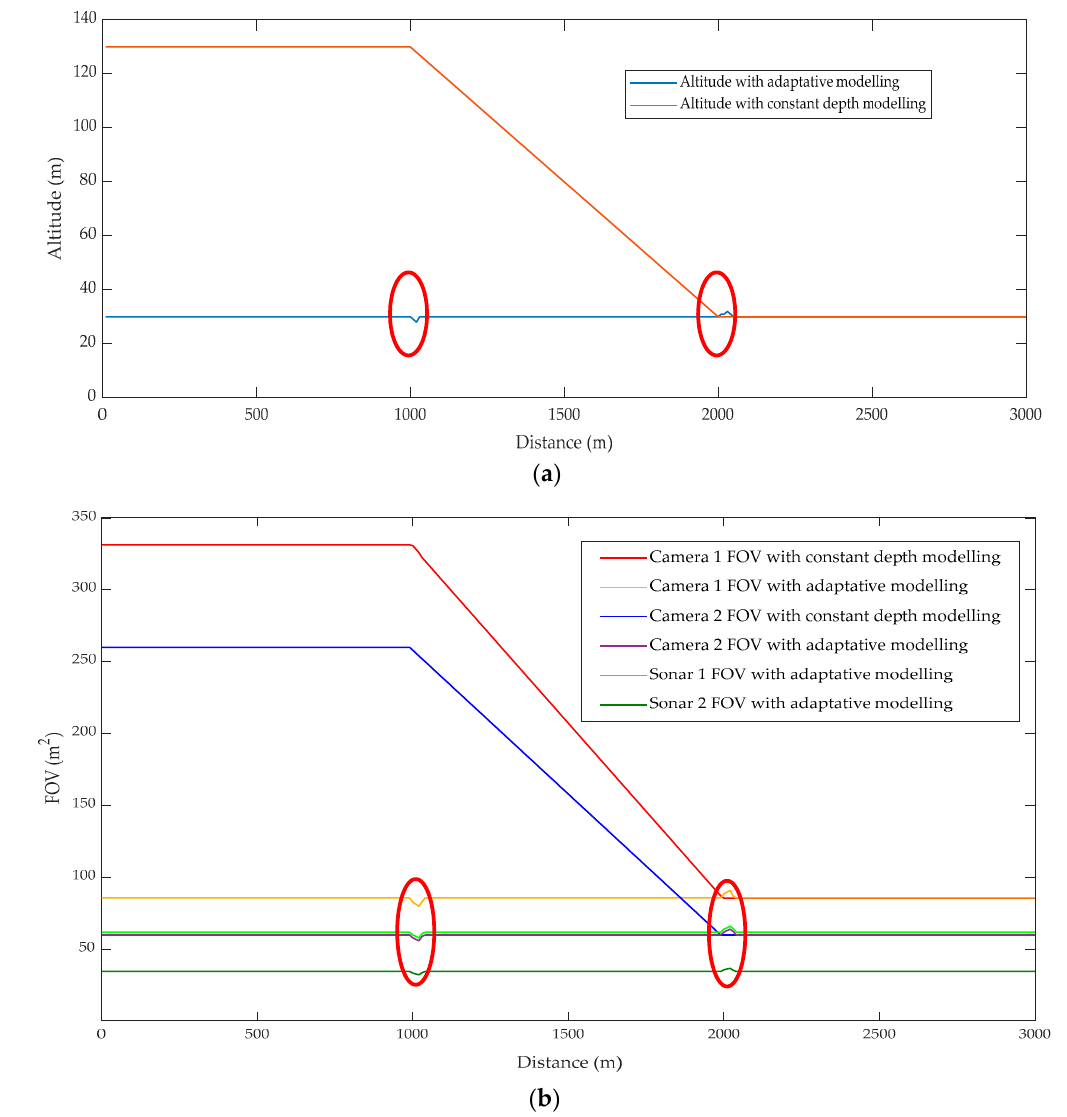
Figure 11. ( a ) Altitude for both navigation models. ( b ) FOV for both navigation